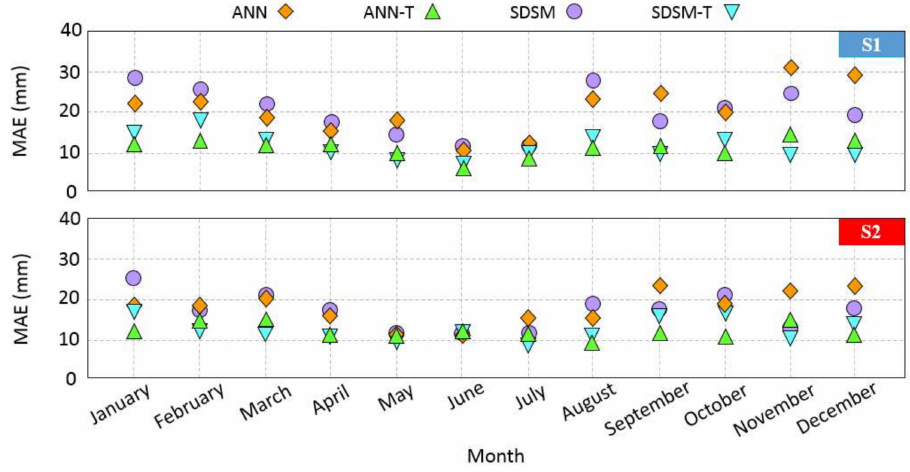
Figure 11. Average monthly precipitation MAE from 2016 to 2020. Table 5. Obtained RMSE for each mode (the best results of each month are highlighted in green). S1 S2